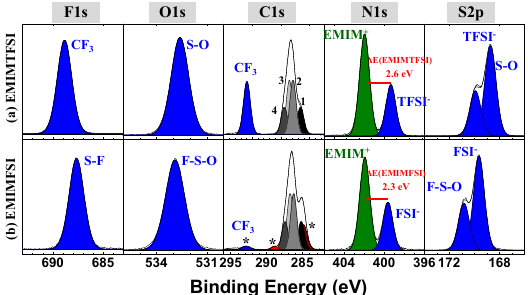
Fig. 2. F1s, O1s, C1s N1s and S2p XPS core